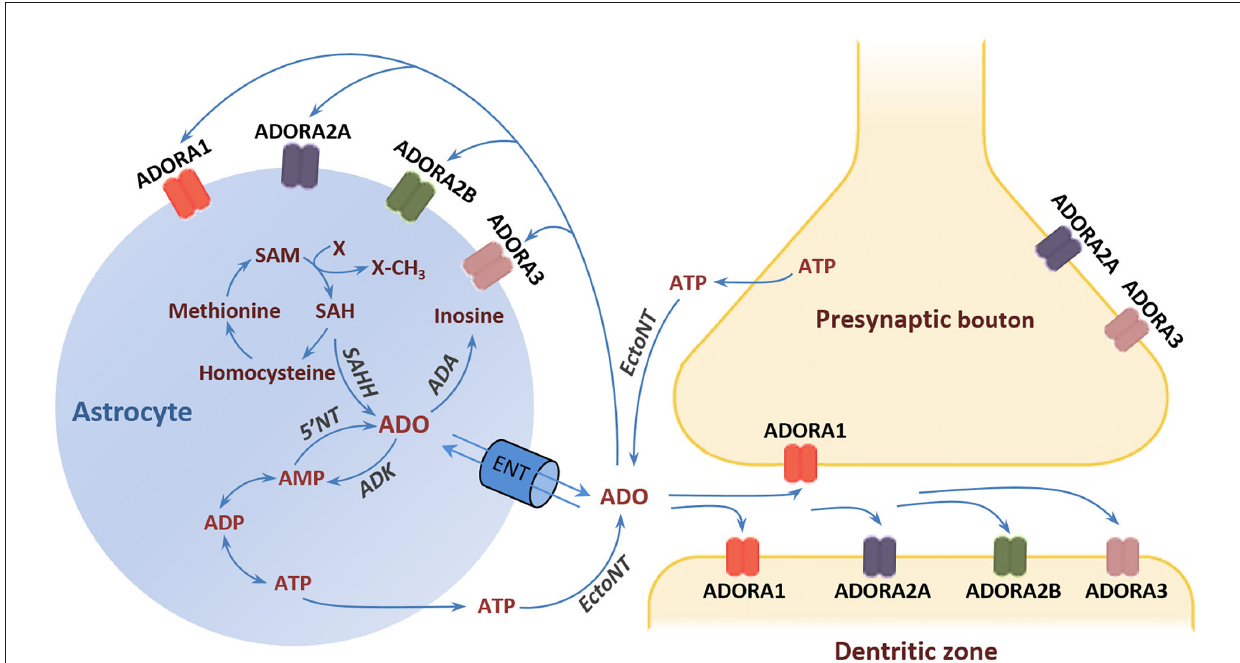
FIGURE1 Adenosine receptors and metabolism. The major source of extracellular adenosine is the extracellular degradation of ATP and AMP by EctoNTs (Latini and Pedata, 2001; Pascual et al., 2005). Astrocytes can release ATP via vesicle exocytosis or hemichannels (Boison et al., 2010). In addition, adenosine can be directly released form astrocytes through ENTs following elevation of the intracellular adenosine concentration through hydrolysis of AMP and SAH by 5‘NT and SAH, respectively. The adenosine reuptake through ENTs is driven by the action of the intracellular enzyme ADK, which phosphorylates adenosine into AMP. ADK is considered the key regulator of extracellular adenosine under physiological conditions (Studer et al., 2006). An alternative metabolic route that comes into play under conditions of increased adenosine is the deamination of adenosine to inosine by the enzyme ADA (Lloyd and Fredholm, 1995). Adenosine exerts its effects through the activation of four types of G-protein-coupled receptors: ADORA1, ADORA2A, ADORA2B, and ADORA3 (Fredholm et al., 2005; Chen J.-F. et al., 2014). Abbreviations : ADA, adenosine deaminase; ADK, adenosine kinase; ADORA1, adenosine A1 receptor; ADORA2A, adenosine A2A receptor; ADORA2B, adenosine A2B receptor; ADORA3, adenosine A3 receptor; AMP, adenosine monophosphate; ADP, adenosine diphosphate; ATP, adenosine triphosphate; 5’NT, 5’-nucleotidase; EctoNT, ectonucleotidase; ENT, equilibrative nucleoside transporter; SAH, S-adenosylhomocysteine; SAHH, S-adenosylhomocysteine hydrolase; SAM,